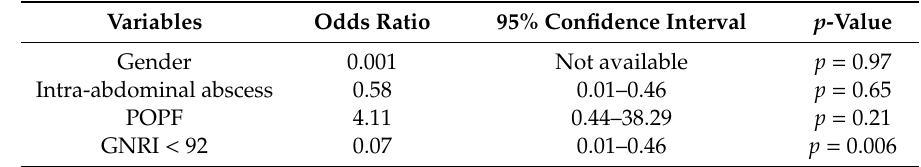
Table 2. Multivariate analysis by logistical regression. GNRI < 92 was an independent risk factor for PPH following PD.